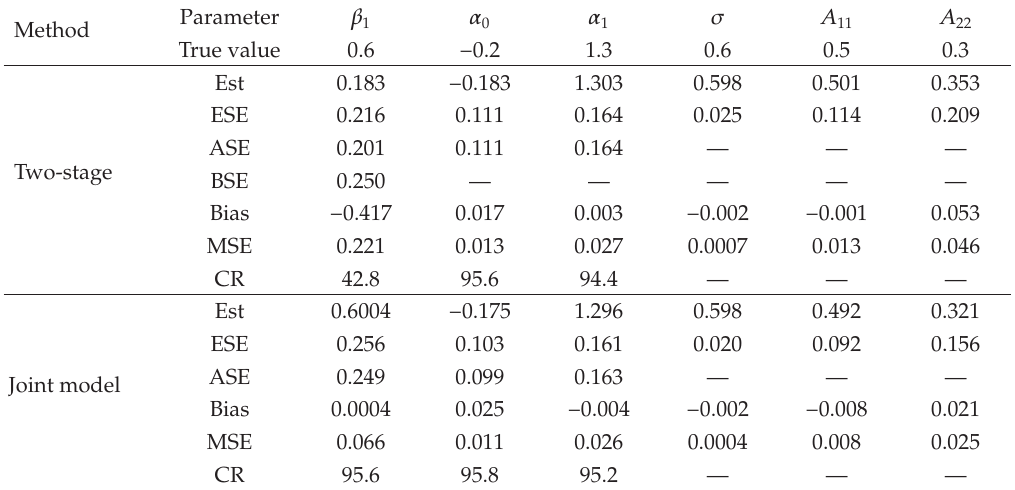
Table 2: Comparison of the two-stage Method and the joint likelihood method via a simulation